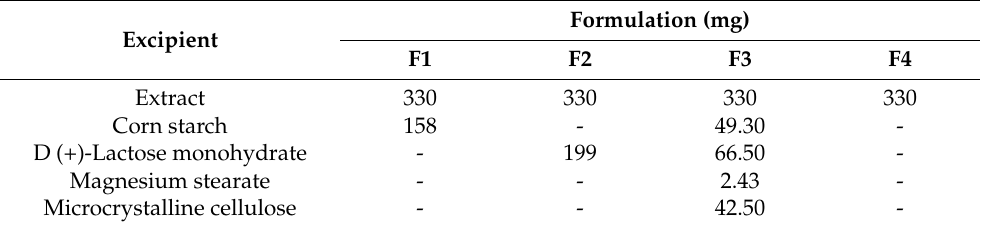
Table 3. Composition of the